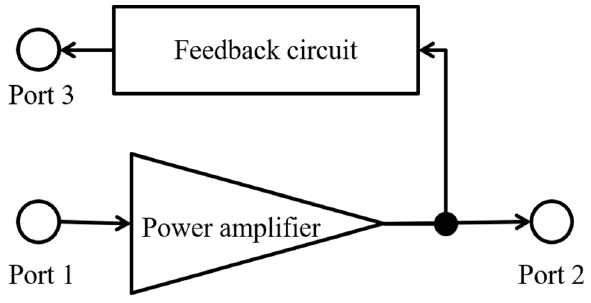
Figure 5. Block diagram of the high power oscillator.